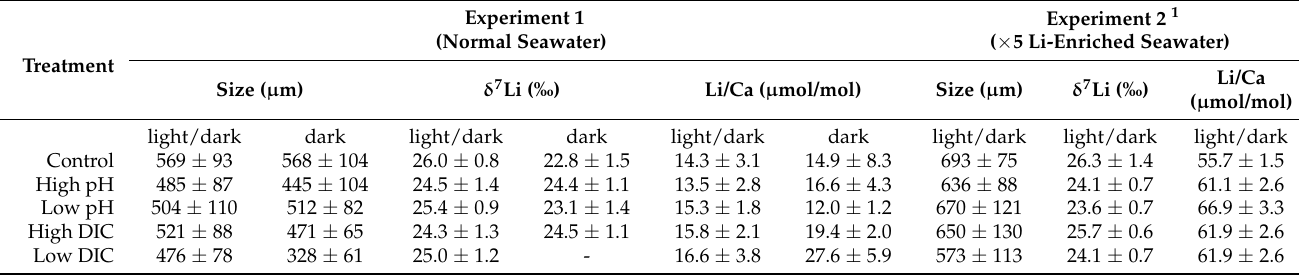
Table 2. Specimen size at the end of the culture period, δ 7Li values, and Li/Ca ratios in Amphistegina lessonii for all treatments in both experiments. Note that δ 7 Li values in the specimens grown under low-DIC and dark treatment in experiment 1 could not be measured (see text for details). Uncertainties represent the external error (2 σ